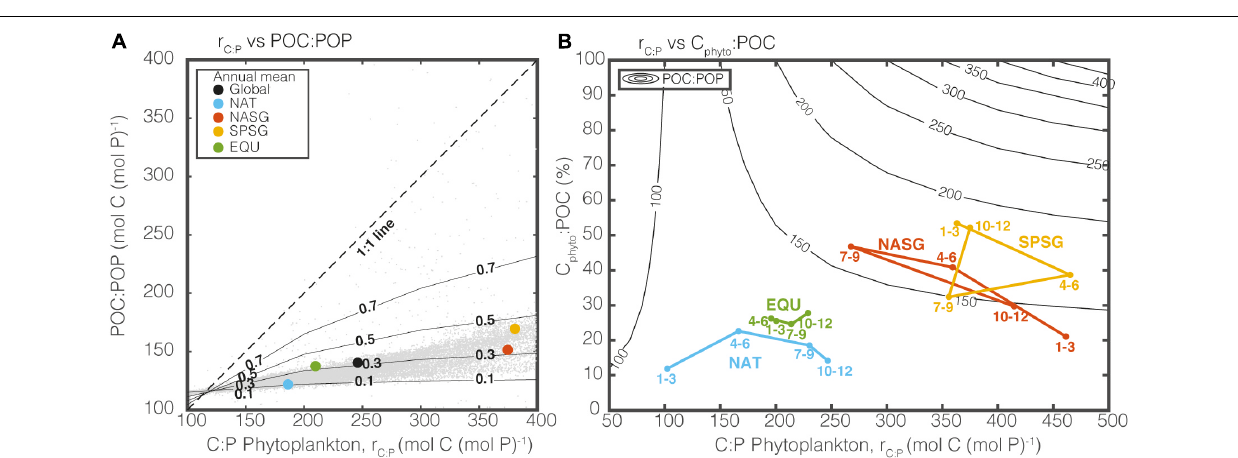
Figure 6B is an alternative way of illustrating this top- down control on bulk POC:POP by community composition. Contour lines representing POC:POP based on our simple two end-member algal/non-algal mixing model are widely separated when C phyto :POC is low, indicating that POC:POP is relatively stable when C phyto :POC is relatively low. On the other hand, when C phyto :POC is high, contour lines become closer together, and bulk POC:POP quickly approaches r C : P